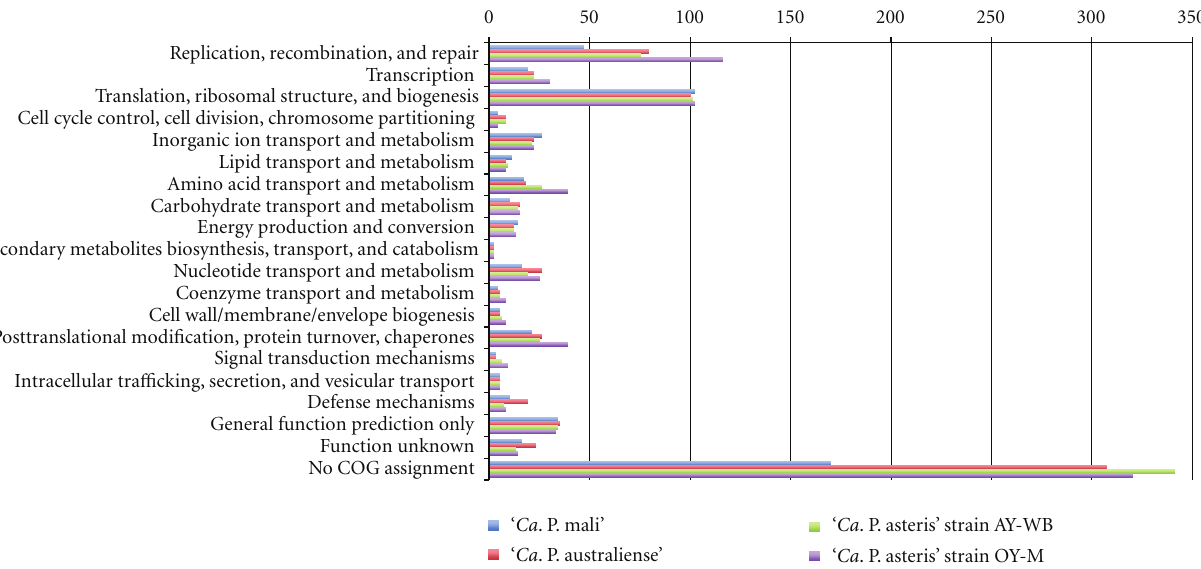
Figure 3: COG assignment of the deduced proteins of the four phytoplasma genomes. Single deduced proteins can show more than one assignment to the COGs